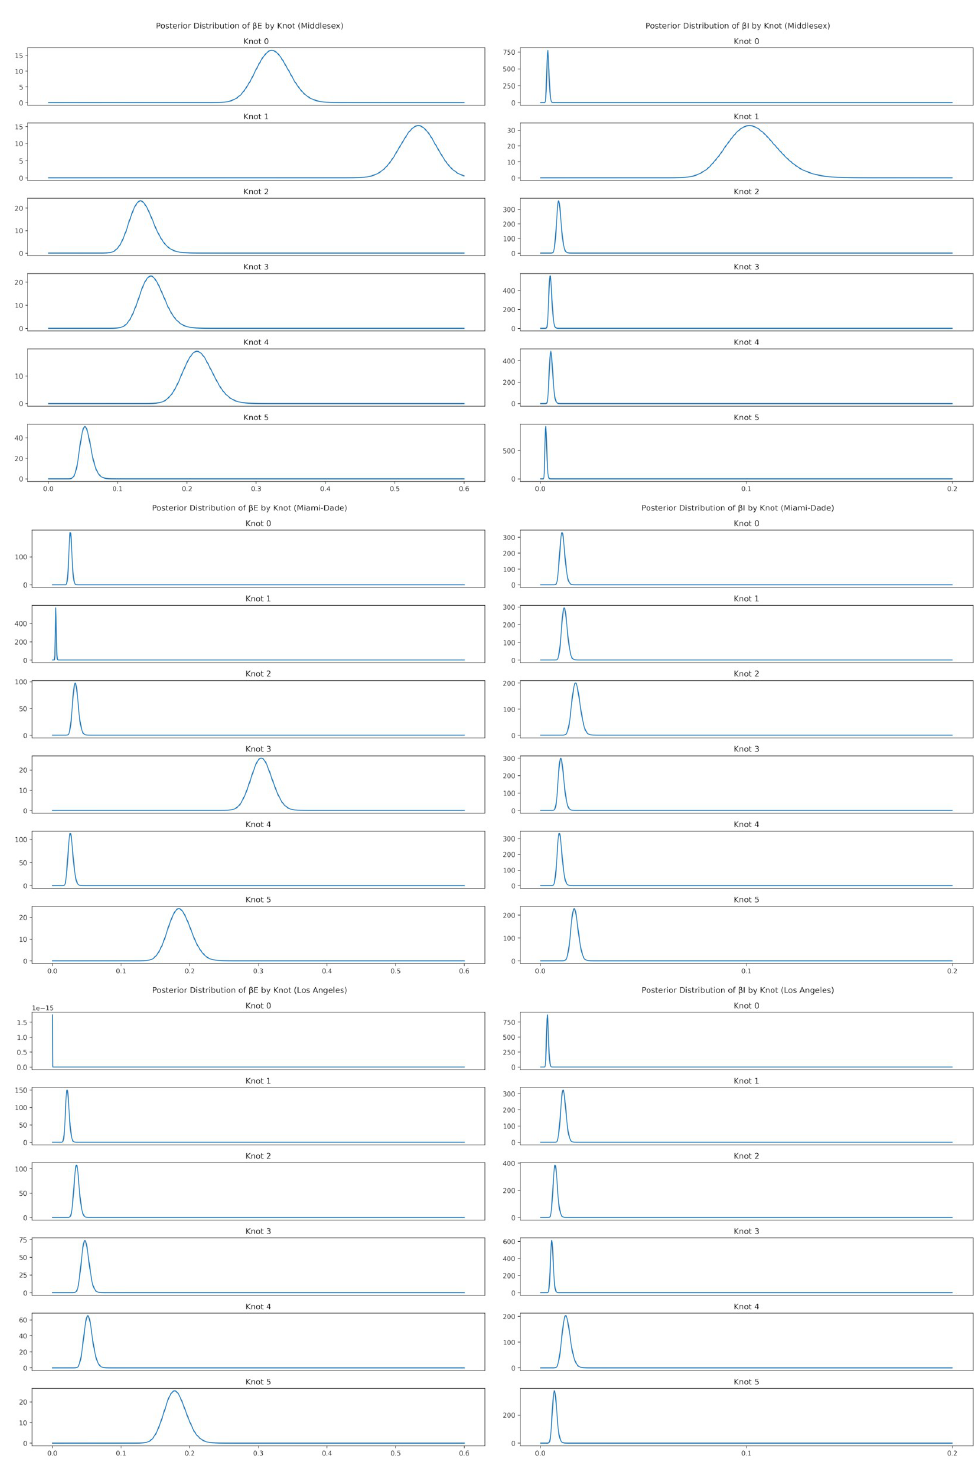
Fig 8. Posterior distribution of b t n